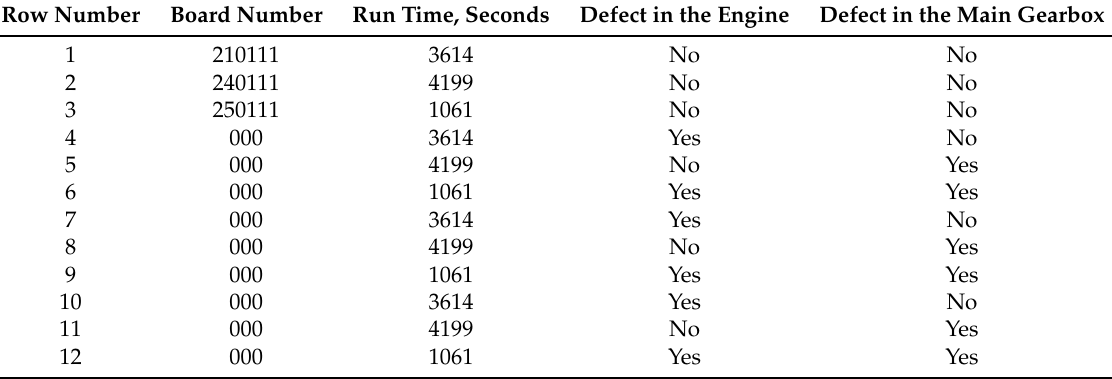
Table 4. Description of technical